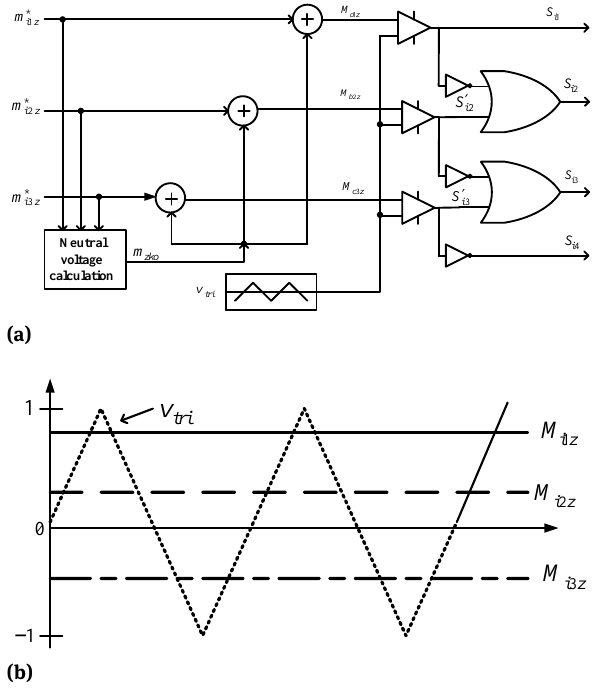
Figure 4: 12-switch converter CBPWM modulator: (a) block diagram of switching logic, and (b) triangle intersection of N modulation signals. Table 2: Parameters of simulations and experimental